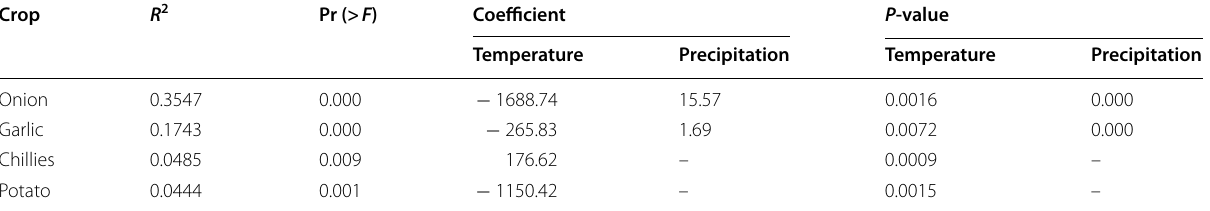
Table 6 Linear regression analysis between climate variables (precipitation and temperature) and average production (kg/ha) during 2000–2015 shows that variation in the chillies, garlic, potato and onion crop yield is significantly impacted by climate